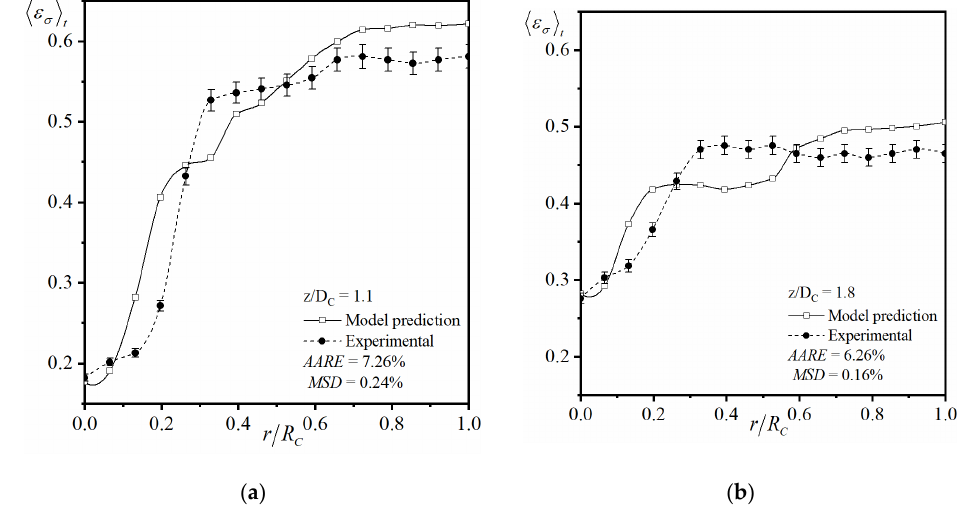
Figure 10. Experimental and model predicted time-averaged radial solids holdup distribution for a spouted bed packed with 1.41 mm glass beads, 325 mm H ( b ) z / D C = 1.8.